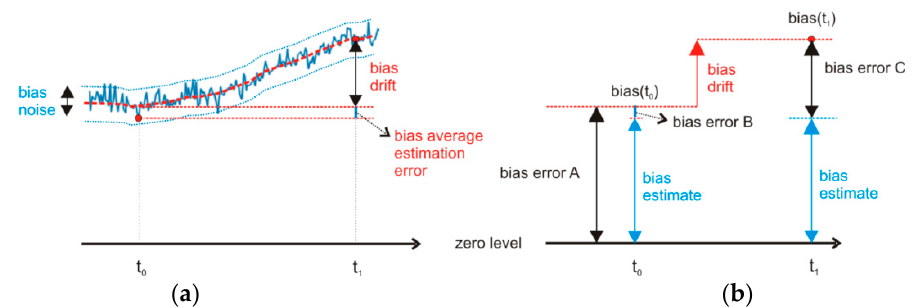
Figure 5. Bias variations and their effects. ( a ) The bias changes with time (blue line) in the short term primarily because of bias noise (ARW) and in the long term because of other influences (red dashed line). Bias drift is the change in bias value between times t 0 and t 1 ; ( b ) Without compensation, we experience bias error A . With the compensation at time t 0 , we decrease the bias error for the measured bias estimate to get bias error B . By time t 1 , the bias drift causes the error to grow to the value of bias error C .